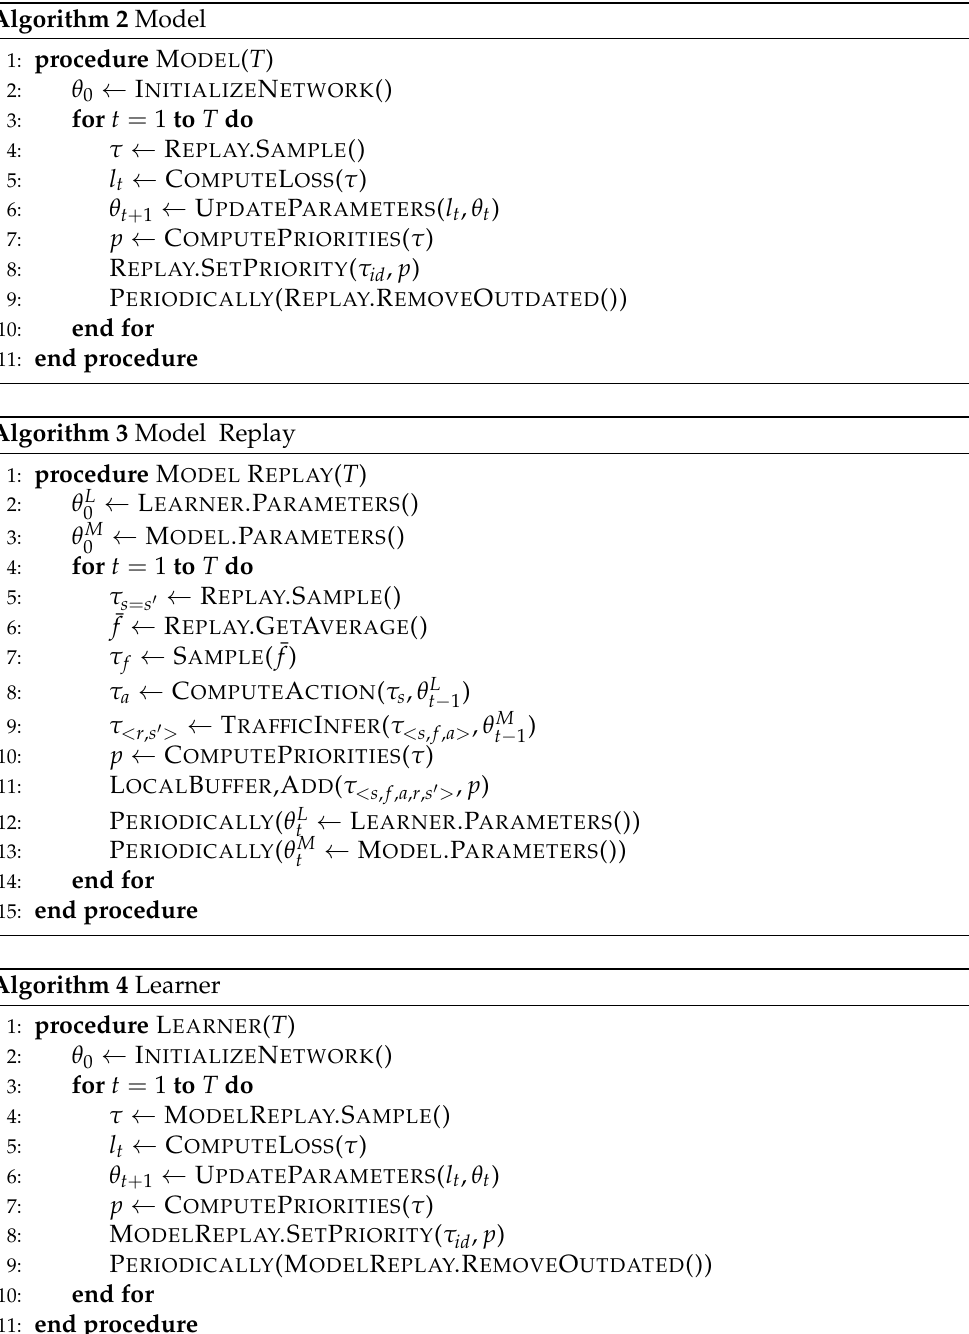
Algorithm 2 Model